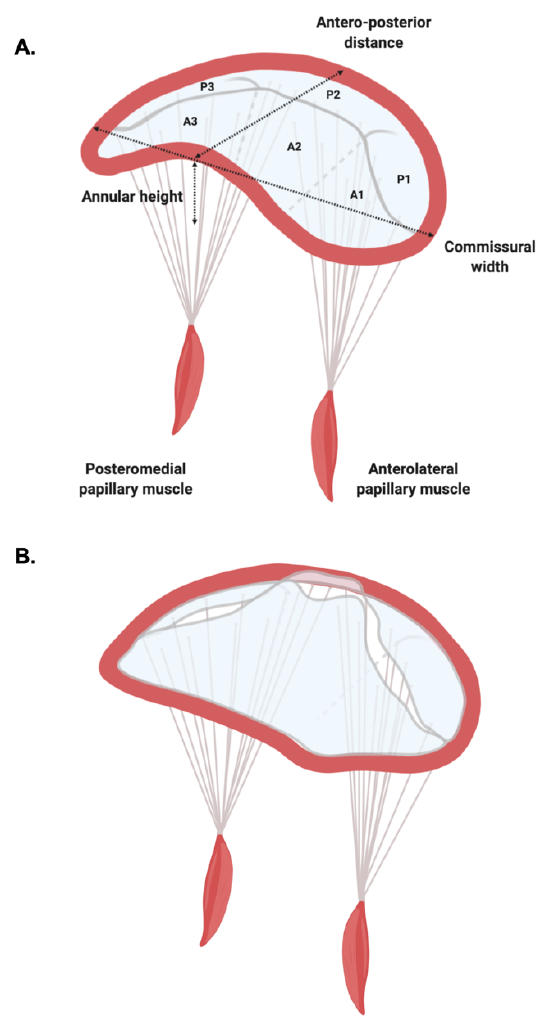
Figure 1. Mitral Valve Anatomy. ( A ) Normal valvular anatomy, with the saddle-shaped annulus and two leaflets, divided according to the Carpentier classification. ( B ) Mitral valve prolapse is characterized by superior displacement of one or both leaflets into the left atrium. Other than the prolapse, the mitral valve undergoes profound changes in systole with the flattening of the annulus and the increase of posterior circumference.